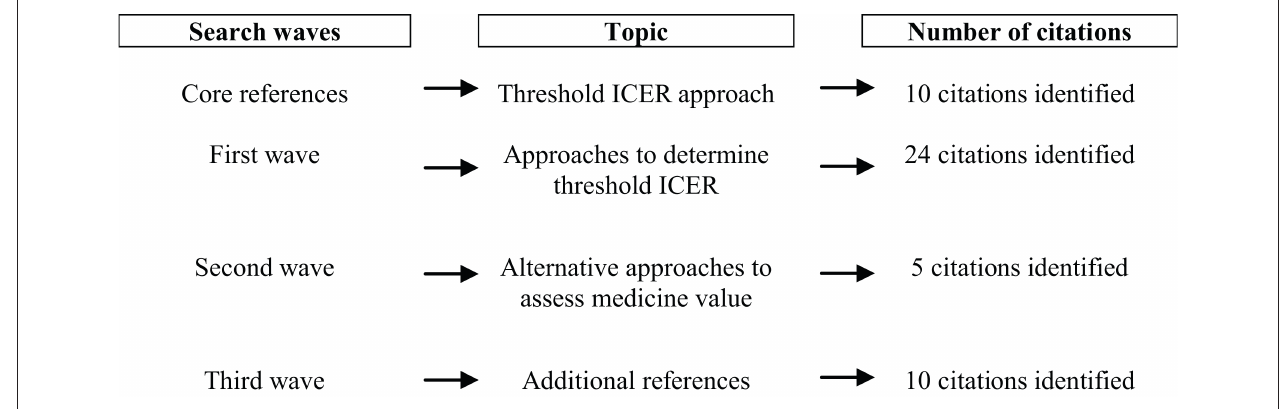
Figure 1 | Flow chart of literature